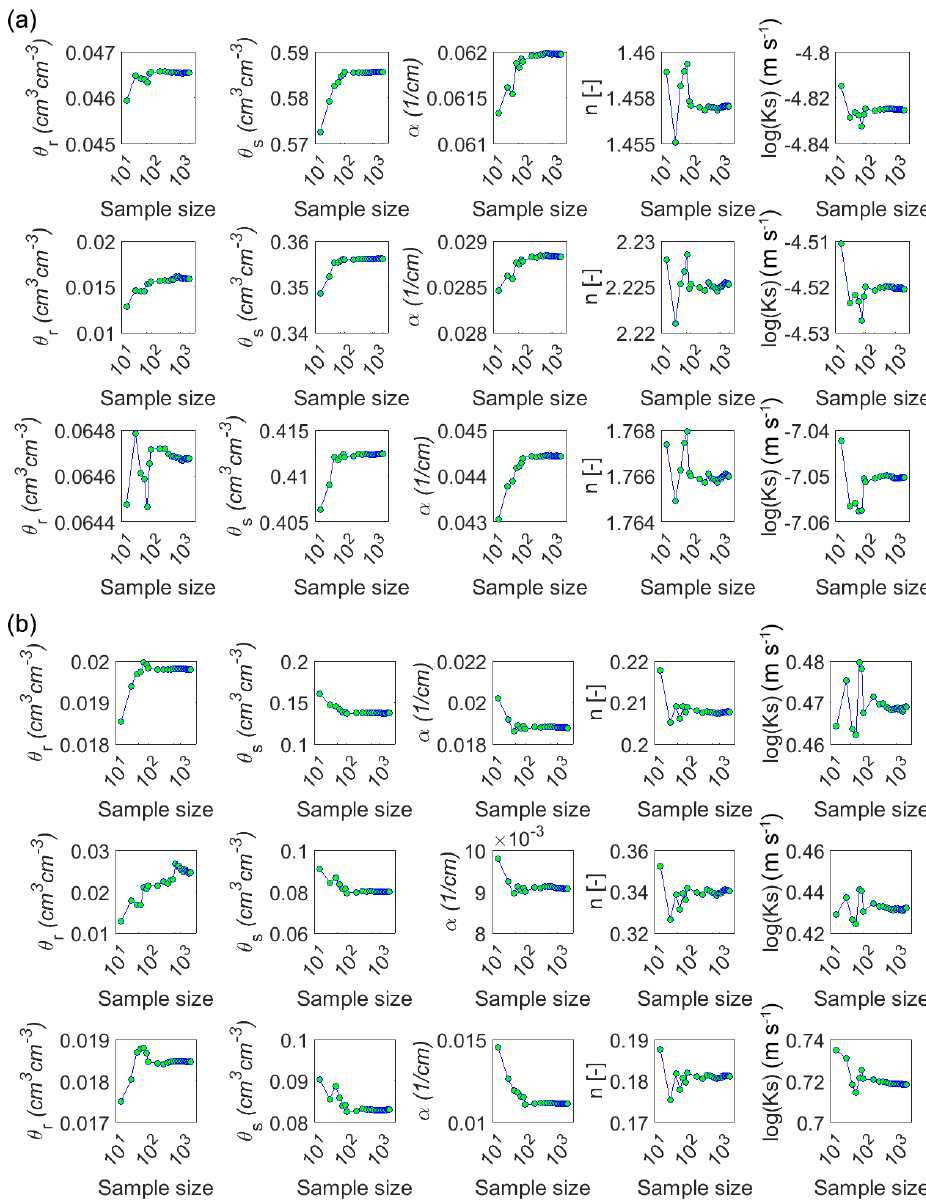
Figure 9. (a) Mean and (b) SD of the sampled parameter values corresponding to each sample size. Results are shown for peat (top row), subsoil (middle row), and LOS (bottom row) in both (a, b)